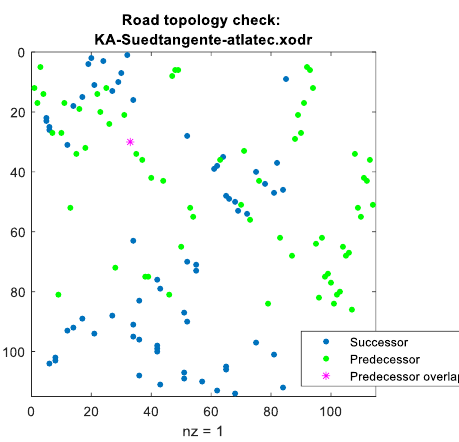
Figure 9. The visual result of the topology check The complete topological inspection of the Karlsruhe-model took only a couple of seconds on a medium category laptop. algorithm: An overview of publicly available